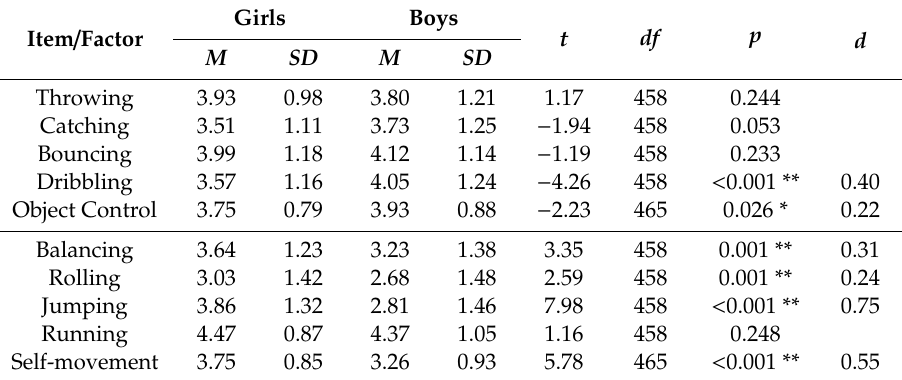
Table 4. Descriptive results of perceived MC according to